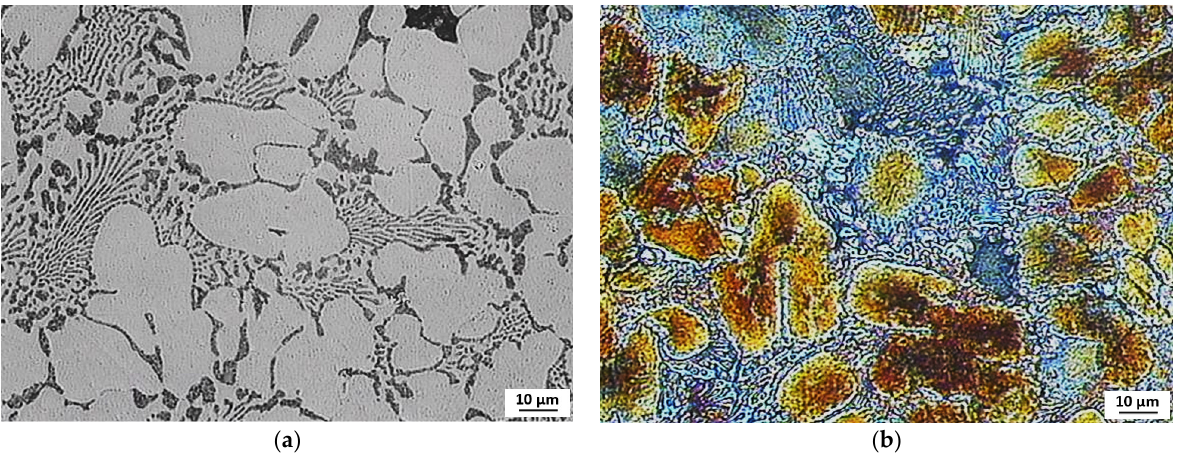
Figure 8. Microstructure of the ZnAl4Cu3 sample after fifth melting (P5 alloy): ( a ) etched 0.5% HF and ( b ) etched Dix–Keller.